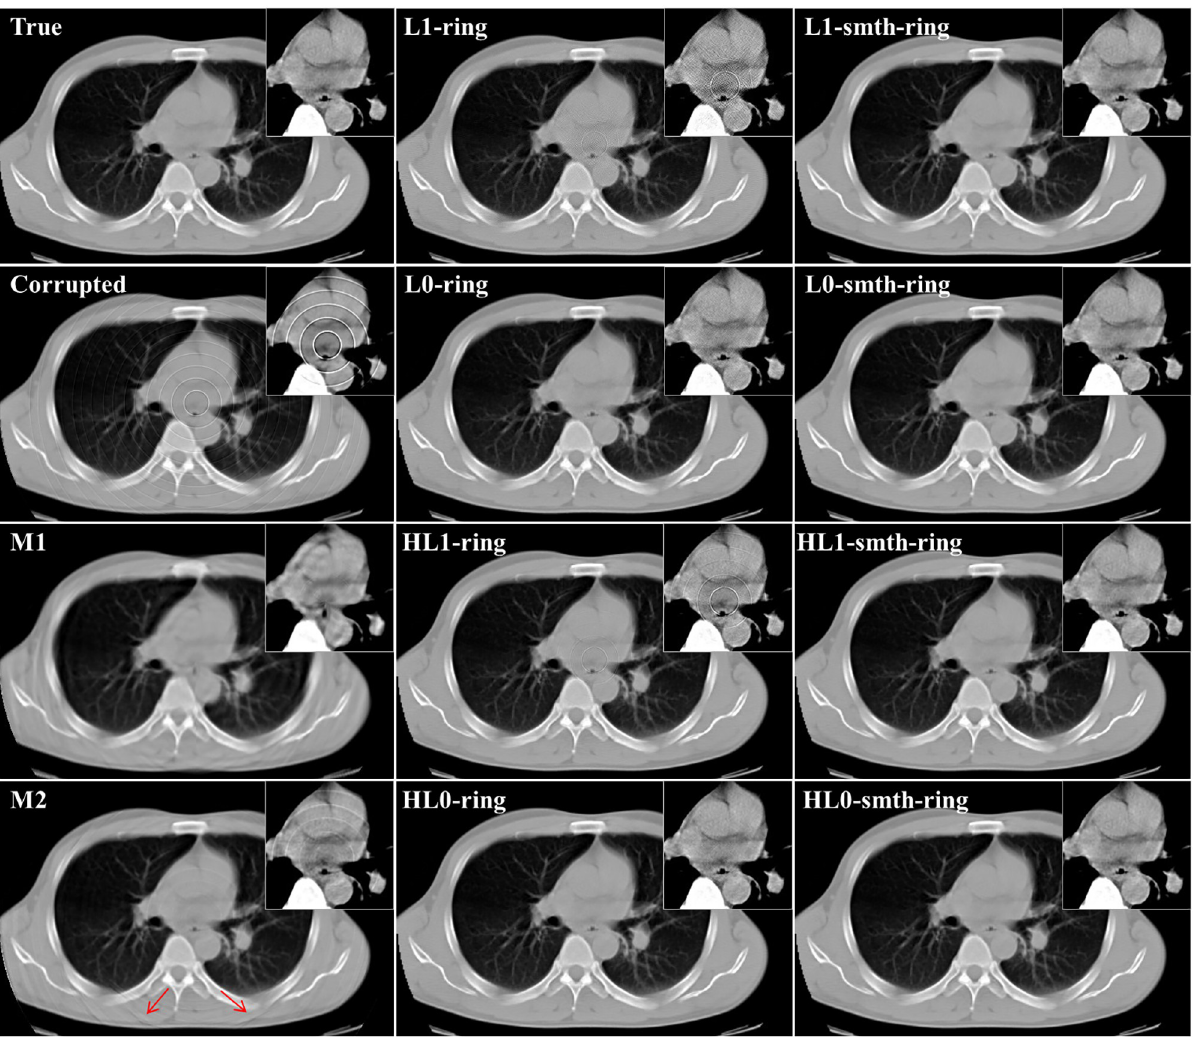
Fig 3. Reconstructed images in the first study case (noise-free, non-adjacent error detector bins, and angular-independent error case).